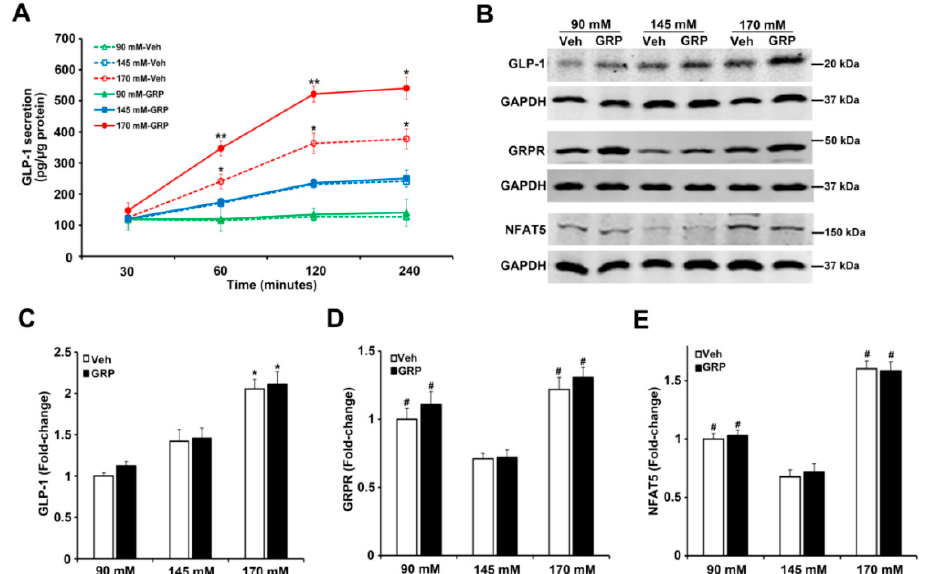
Figure 4. Effect of different concentrations of sodium and GRP on GLP-1 secretion and expressions of GLP-1, GRPR, and NFAT5 in ileum from BALB/c mice. ( A ) The effect of 90 mM, 145 mM, and 170 mM NaCl on GLP-1 secretion in ileal slices. The ileal slices were exposed to 90 mM, 145 mM, or 170 mM NaCl, and treated with 1000 nM GRP at 30, 60, 120, and 240 min. n = 3/group, * p < 0.05 ** p < 0.01 vs. all others at the same time point, Two-way ANOVA (F = 14.56; p < 0.0001), followed by a Bonferroni multiple comparison test, n = 5/treatment. ( B ) At the end of the treatment, the tissues were collected and subjected to immunoblotting for GLP-1, GRPR, and NFAT5 protein. One set of blots from three independent experiments is shown. ( C – E ) quantifications of GLP-1,GRPR, and NFAT5 protein in ileal slices after treatment for 4 h. GAPDH protein was used for normalization of the data. Quantifications were finally expressed as fold-change, relative to the 90 mM NaCl. n = 3/group, * p < 0.05 vs. 90 mM or 145 mM. # p < 0.05 vs. 145 mM. One-way ANOVA, Holm–Sidak test. VEH =